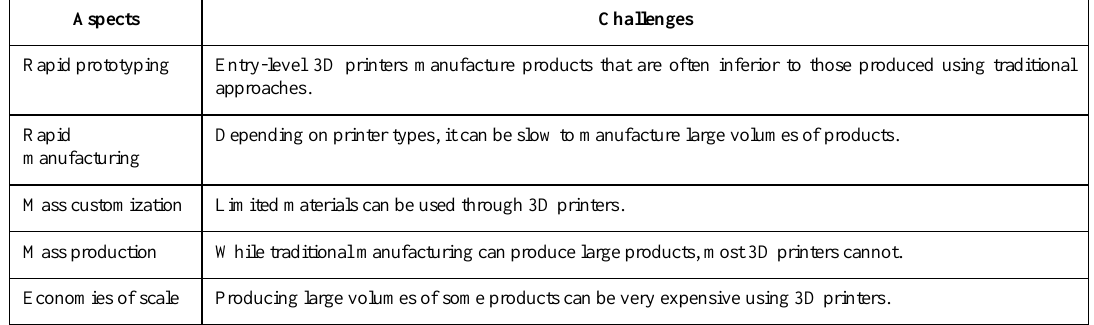
Table 8. Challenges of 3D